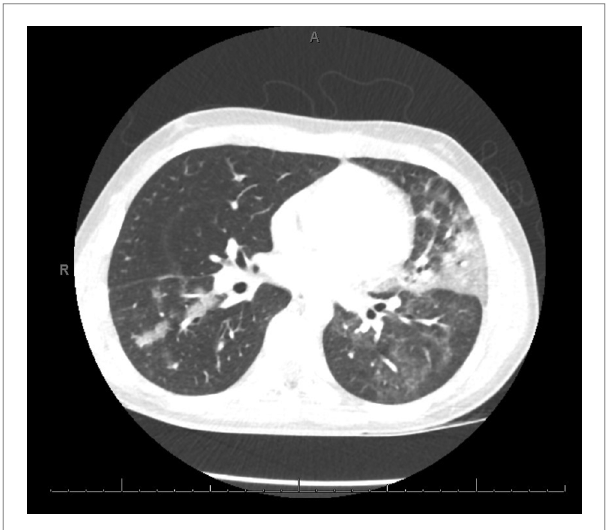
FIGURE 1 The patient underwent a computed tomography (CT) scan of the chest on hospital day (HD) 4 which revealed “ bilateral patchy consolidations with adjacent, scattered ground glass opacities ”